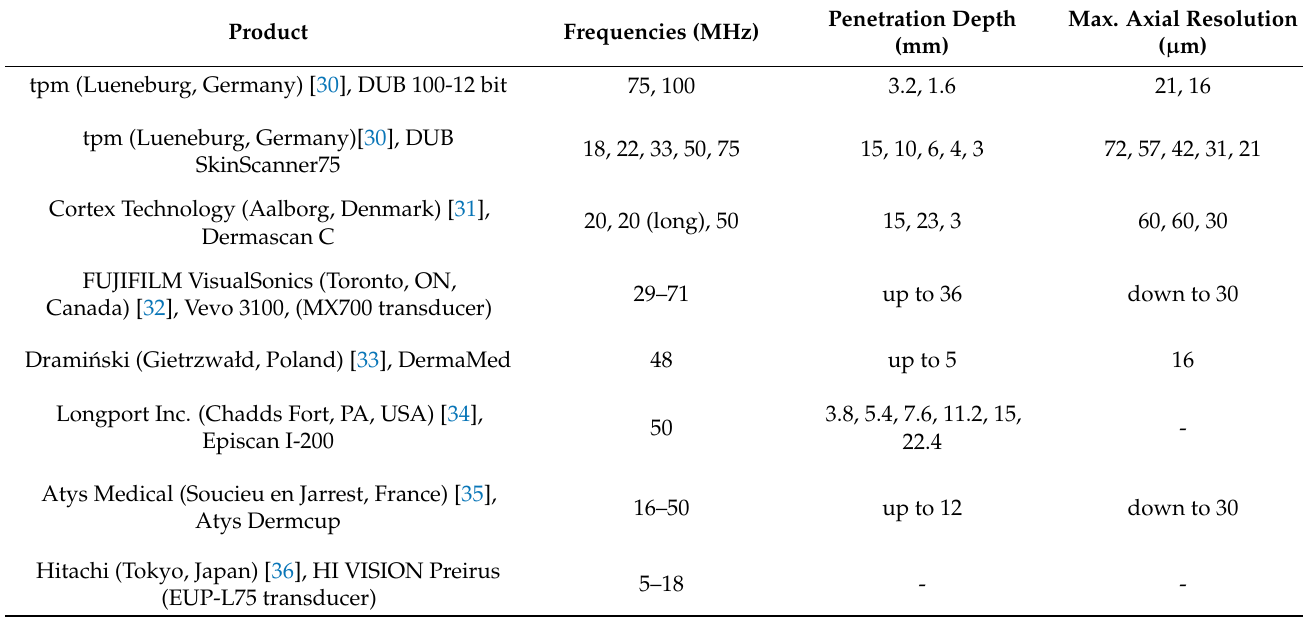
Table 1. HFUS machines available on the market and their acquisition parameters.